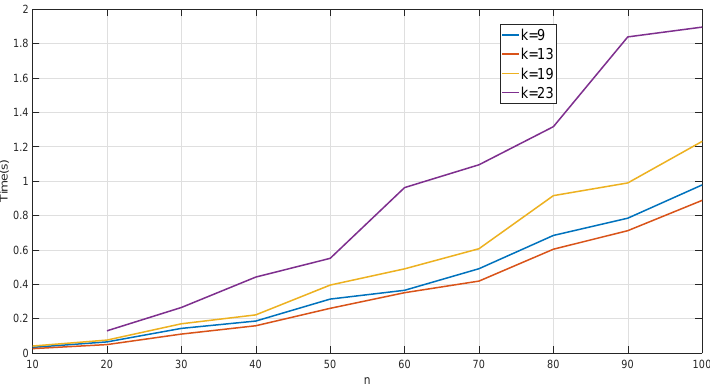
Figure 2. Calculation time with different dimensions when the diagonal number k = 9,13,19,23.